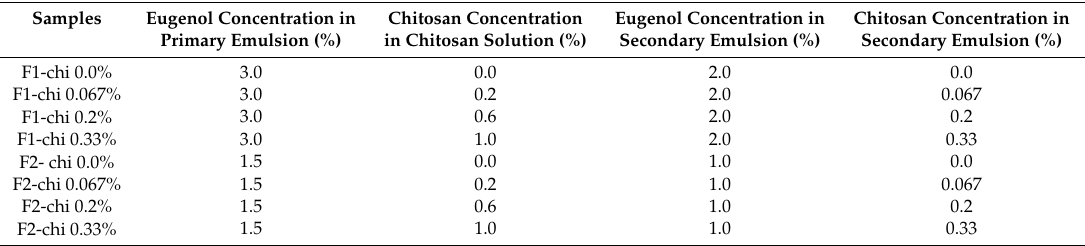
Table 1. The formulation of emulsion and name of the samples